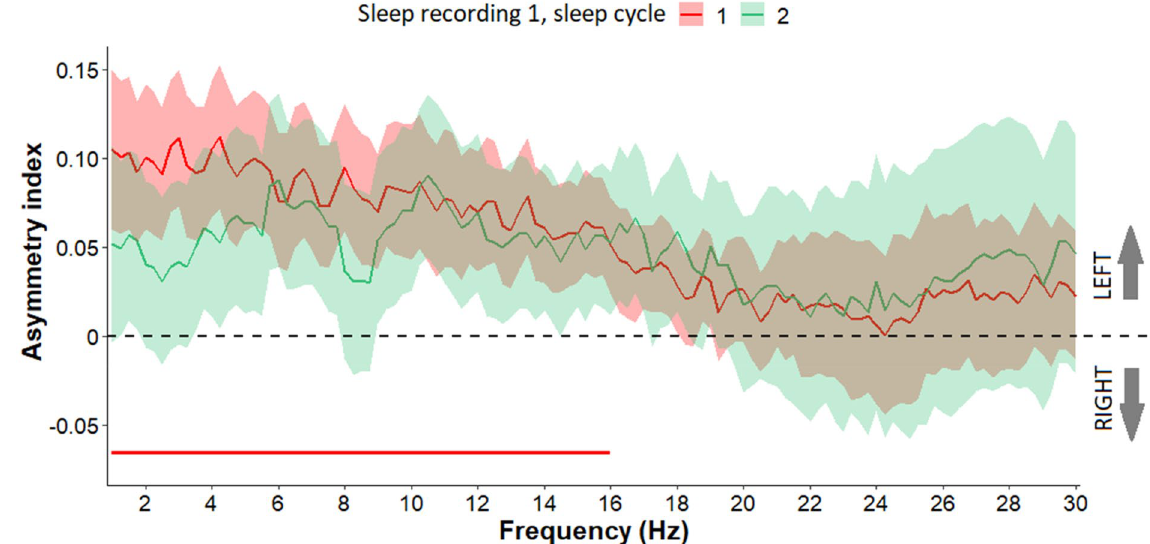
Figure 3. Asymmetry index values (Mean + / − SE) in frequency range 1–30 Hz in the first and second sleep cycle of sleep recording 1. Compared to baseline asymmetry (hypothetical zero), left hemispheric predominance was observed in the first sleep cycle of sleep recording 1 in the frequency range 1–12.75 Hz. Frequency bins below the statistical threshold (all p s < 0.05, fulfilling the criteria of a significant Rüger area) are illustrated by a red horizontal line.